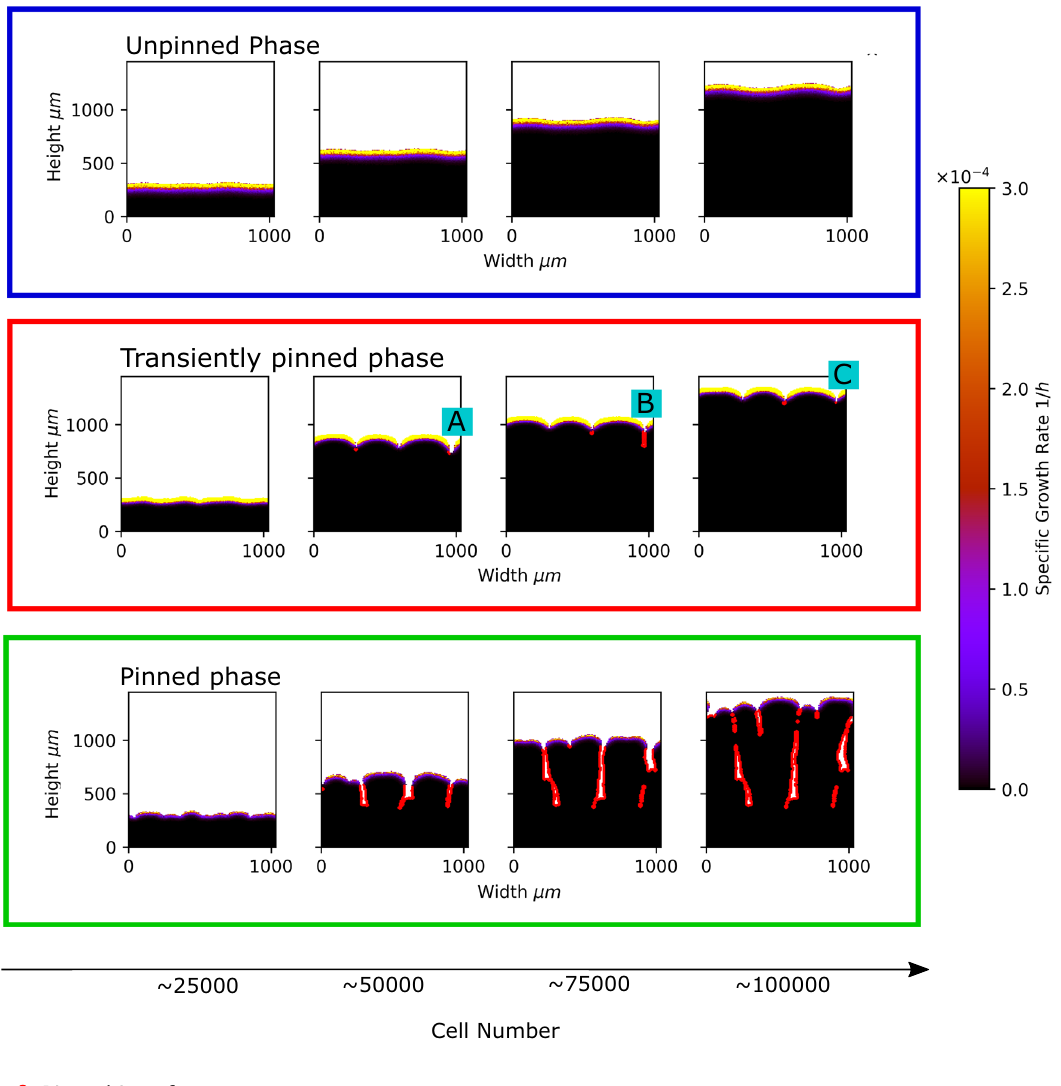
Fig. 4 Distinct phases of bio fi lm dynamics. Bio fi lm growth is illustrated for three parameter sets, representing three qualitatively different types of bio fi lm behaviour, or `phases'. The top row of snapshots is for parameters S bulk = 0.01 g/L, μ max = 0.1 1/h, which represent the unpinned phase. The central row of snapshots is for parameters S bulk = 0.01 g/L, μ max = 0.4 1/h, representing the transiently pinned phase. The bottom row of snapshots is for parameters S bulk = 0.0005 g/L, μ max = 0.4 1/h and represents the pinned phase. Bio fi lm growth is shown from left to right; snapshots are shown for bio fi lm sizes of 25,000, 50,000, 75,000 and 100,0000 cells. In the snapshots, cells are colour-coded according to their speci fi c growth rate. Parts of the interface that are pinned (i.e. have not moved in the previous six hours of simulated time) are represented in red. The parts of the interface labelled A, B and C in the fi gure correspond respectively to a gap in the active layer, a pinning site and a gap in the active layer gap after a pinning site has